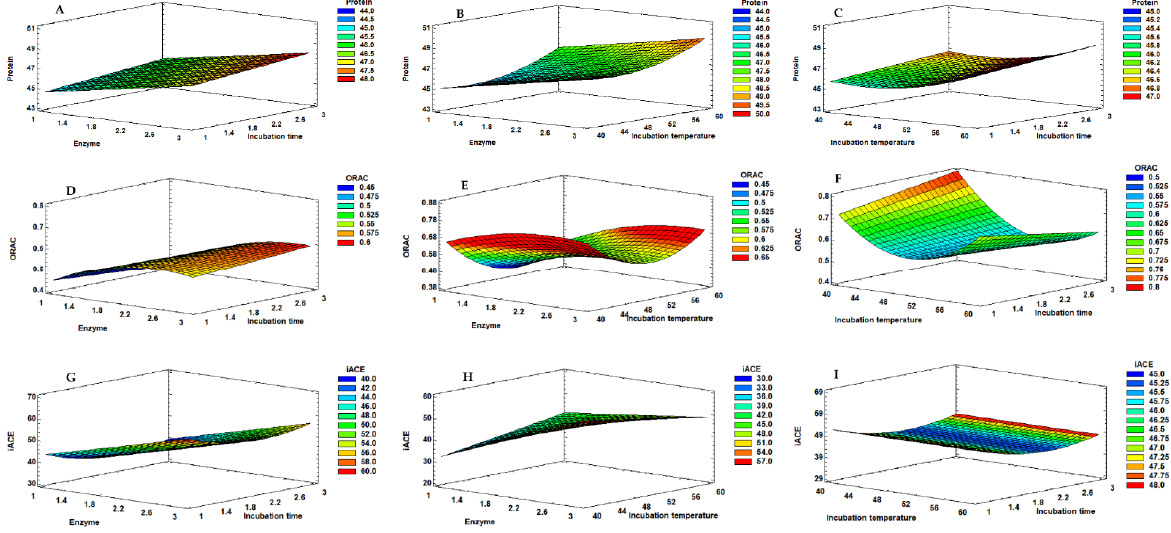
Figure 4. Response surface graphs corresponding to the combined effect of enzyme % (XA), hydrolysis temperature (XB) and hydrolysis time (XC), on the protein ( A – C ), ORAC ( D – F ) and iACE ( G – I ) responses obtained for the mussel extracts produced with corolase.